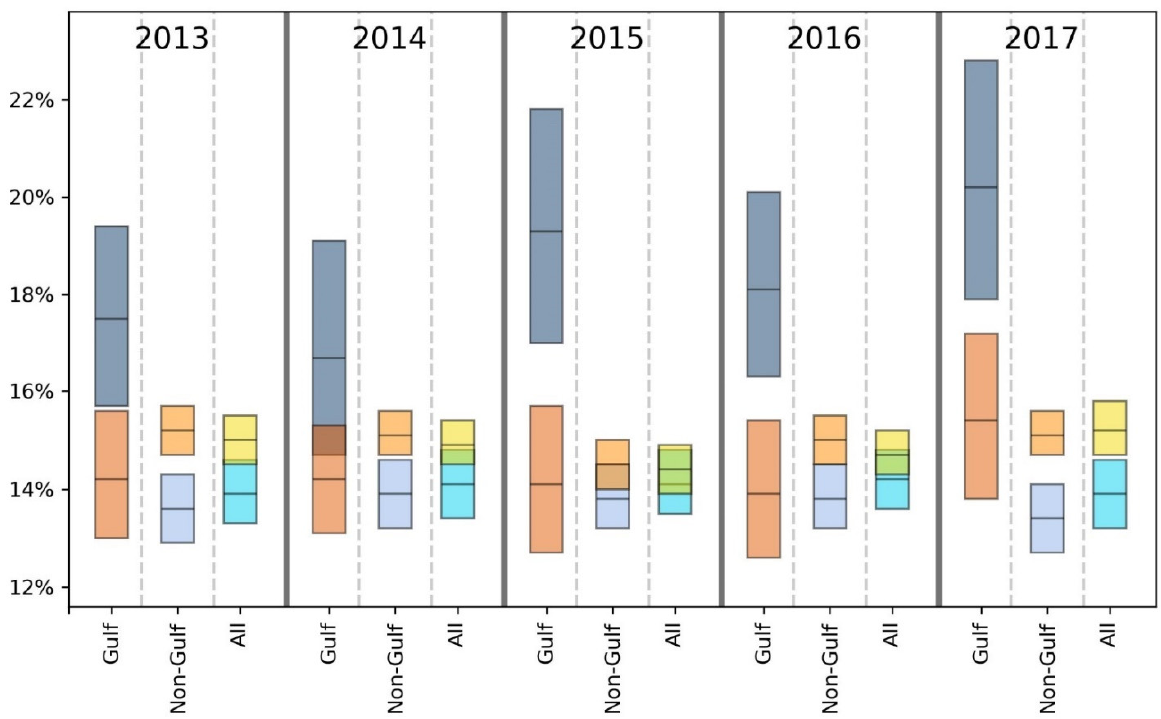
Figure 7. Comparison of mean (black line across bar) and 95% confidence intervals for percentages of Gulf and non-Gulf MMSA respondents reporting ≥ 14 physically or mentally unhealthy days out of the last 30. Colors denote the following: dark blue = coastal Gulf, light blue = coastal non-Gulf, dark orange = non-coastal Gulf, light orange = non-coastal non-Gulf, bright blue = all coastal, yellow = all non-coastal.